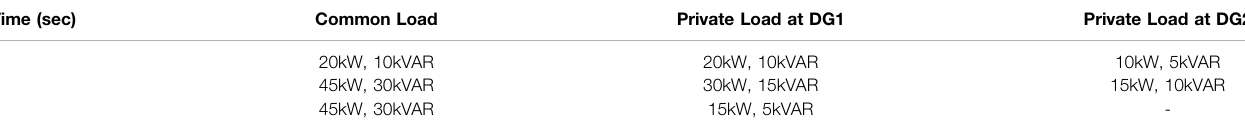
TABLE 4 | Load change for private and common